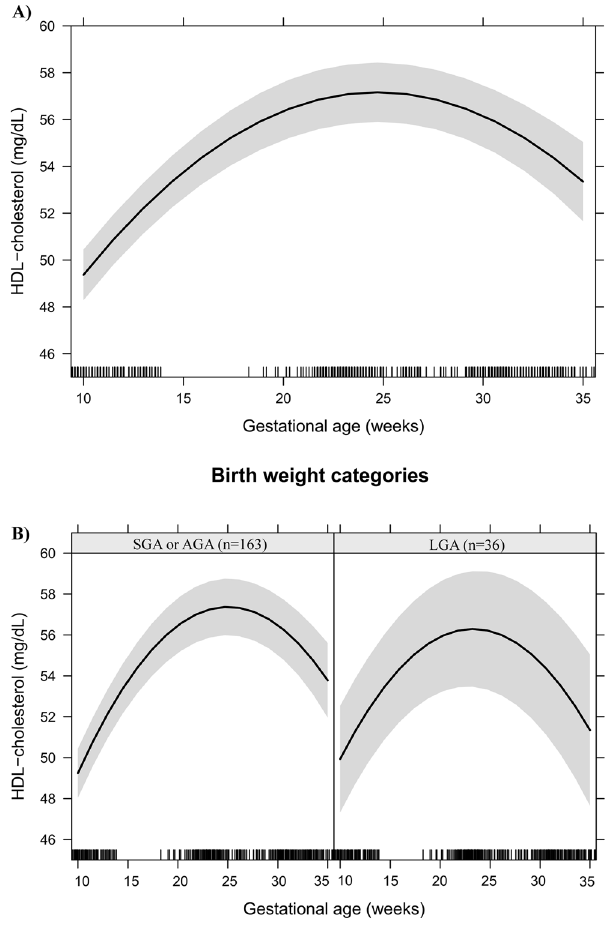
Figure 1. HDL-cholesterol changes during pregnancy in a sample of 199 women and their newborns followed at a public health centre in Rio de Janeiro city, Brazil, 2009–2012. ( A ) Change per gestational week. ( B ) Change per gestational week according to birth weight categories. Note: The models were adjusted for age, education, smoking habit, pre-pregnancy leisure time physical activity, pre-pregnancy energy intake, glycaemia, parity, early pregnancy BMI, gestational weight gain and quadratic gestational age. Data are presented as linear mixed effect coefficient ( β ) and 95% CI. p-value refers to the maximum likelihood estimator. ( A ) Linear gestational age: β = 1.80 (1.52; 2.08), p < 0.001; Quadratic gestational age: β = − 0.04 ( − 0.04; − 0.03), p < 0.001. ( B ) SGA or AGA - Linear gestational age: β = 1.76 (1.44; 2.08), p < 0.001; quadratic gestational age; β = − 0.04 ( − 0.04; − 0.03), p < 0.001. LGA - Linear gestational age: β = 2.04 (1.42; 2.65), p < 0.001; gestational age; β = − 0.04 ( − 0.06; − 0.03), p <